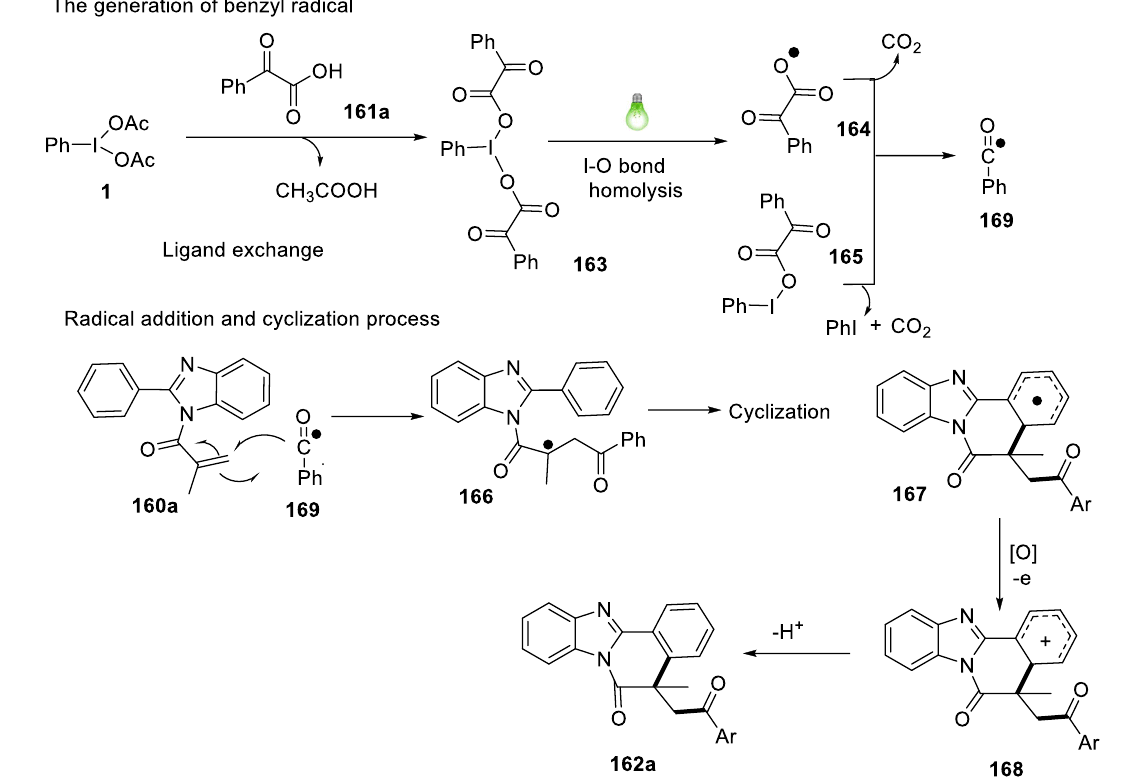
Figure 22. Plausible reaction